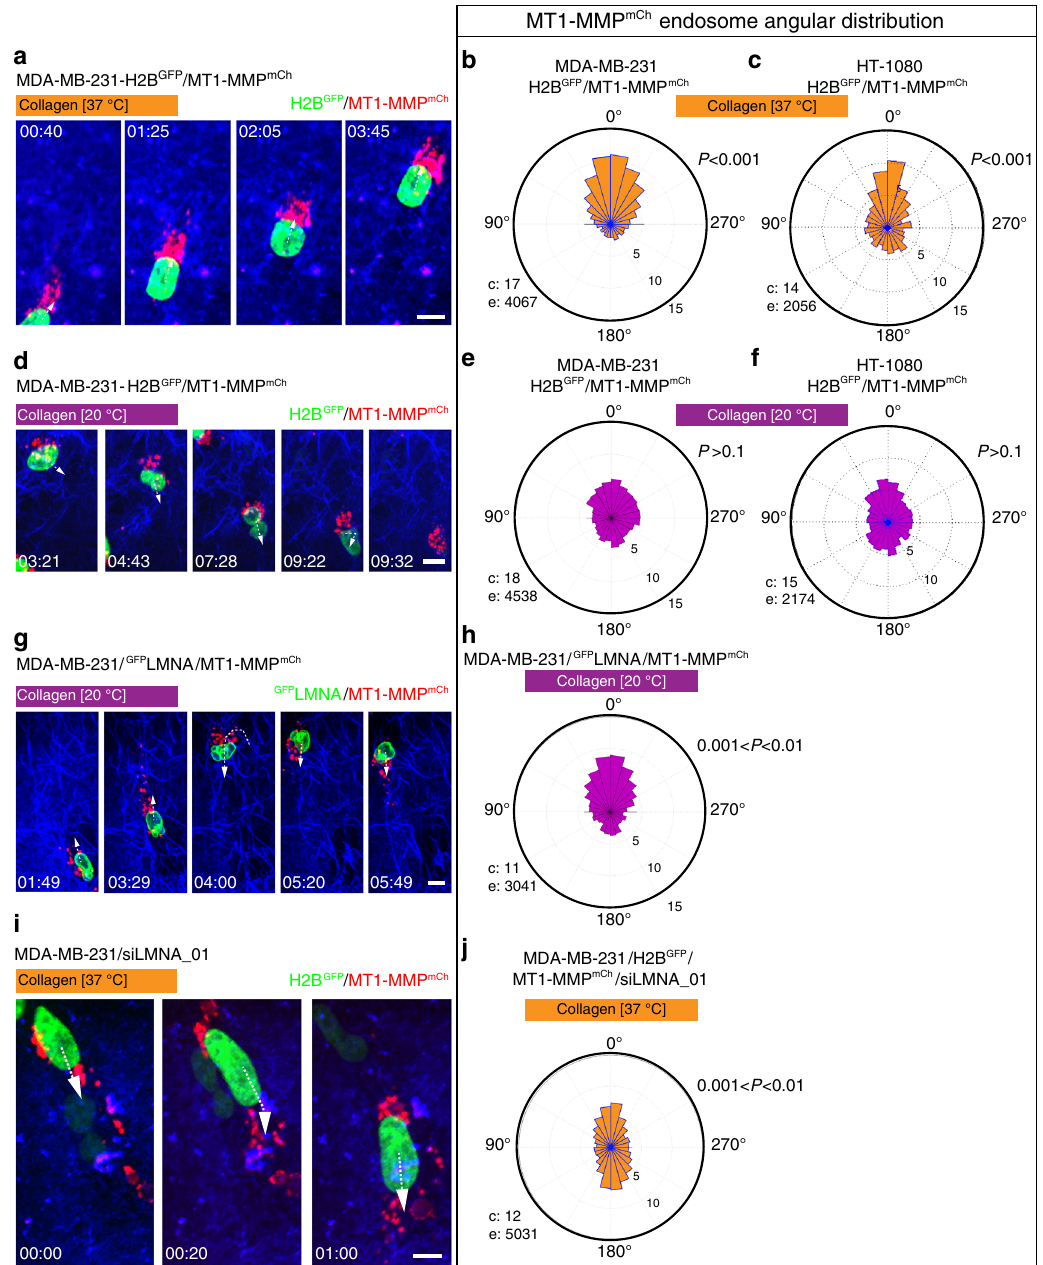
Fig. 2 Polarization of MT1-MMP endosomes is part of the adaptive MT1-MMP-dependent collagenolysis response during con fi ned invasion. a MDA-MB- 231 cells expressing MT1-MMP mCh (red) and H2B GFP (green) were embedded in the 3D small pore size collagen gel and analyzed by time-lapse confocal spinning-disk microscopy (see Supplementary Movie 1). The gallery shows representative non-consecutive frames from a representative movie obtained from three independent experiments (time in h:min). Arrows show the direction of migration. b , c Rose plots showing the percentage of MT1-MMP endosomes in 15° segments relative to the direction of nucleus movement (0°) scored from time-lapse sequences of MDA-MB-231 ( b ) or HT-1080 ( c ) cells. c number of cells, e number of endosomes analyzed from three independent experiments. P -values for circular uniformity Rao ’ s Spacing test are provided. d Representative frames from a time-lapse sequence of MDA-MB-231 cells invading in the large pore size collagen gel (see Supplementary Movie 2). e , f Angular distribution of MT1-MMP endosomes relative to the direction of nuclear movement as in b , c . g Gallery from a representative time-lapse sequence of MDA-MB-231 cells expressing MT1-MMPmCh (red) and GFP LMNA (green) embedded in the large pore size gel (see Supplementary Movie 3). h Rose plot of MT1-MMP endosome angular distribution from three independent experiments. i Representative frames of a movie of MDA-MB-231 cells treated with siRNA against LMNA invading through 37 °C polymerized gel (see time-lapse in Supplementary Movie 4). j Rose plot of MT1-MMP endosome angular distribution from three independent experiments. Scale bars = 10 μ